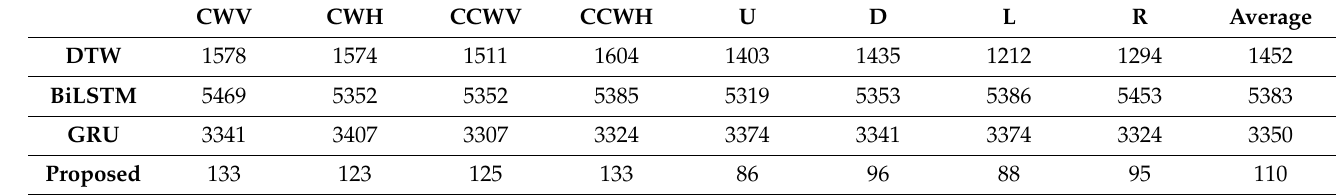
Table 7. Recognition time cost (μs) of four HGR algorithms for each gesture.